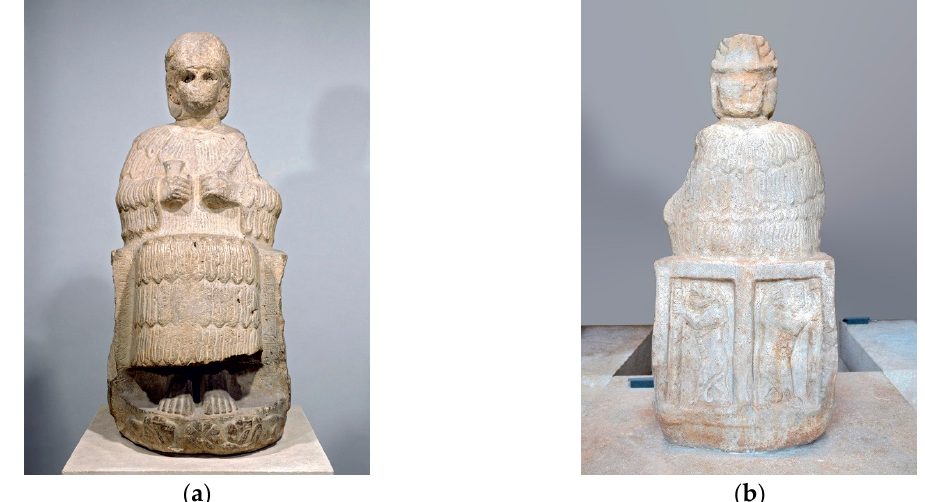
Figure 18. Enthroned goddess Narundi (Louvre inv. nos. Sb 54+6617), front and back (with snarling lions); limestone sculpture; Susa, Elam (mod. Iran); reign of Puzur-Inshushinak, ca. 2100 BCE [photography ( a ) by Pierre and Maurice Chuzeville; courtesy of the Louvre Museum, Paris; ( b ) by Arts 2021 , 10 , x FOR PEER REVIEW Darafsh Kaviyani; CC BY-SA 3.0 License].